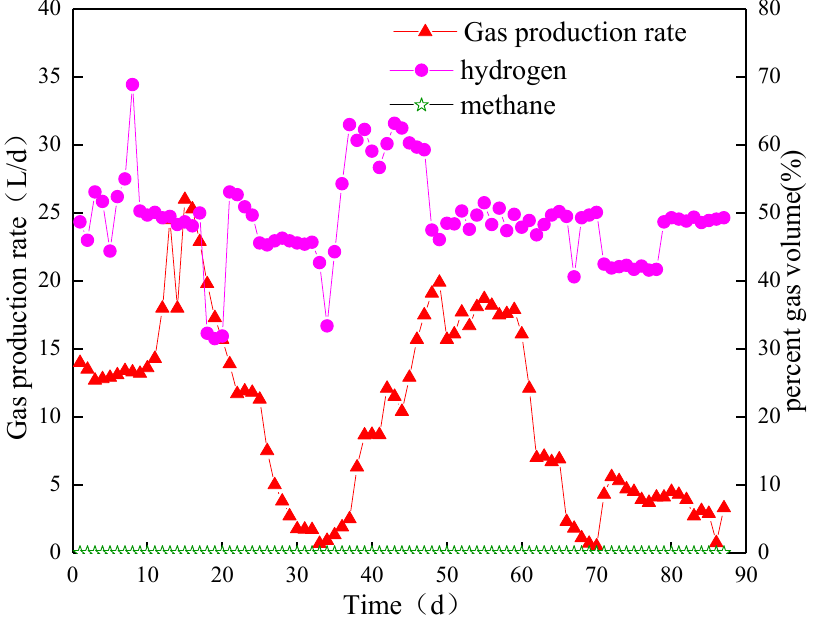
Figure 4. Biogas yield and content in Compartment I.